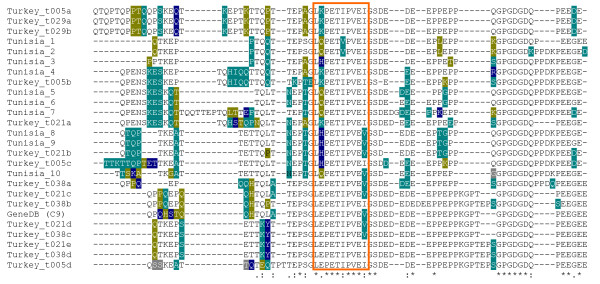
Hypervariable region of SVSP1. Amino acid sequences representing alleles of SVSP1 were aligned, identifying hypervariability in the PEST domain in the centre of the protein. At each site the second (green), third (gold), fourth (blue) and fifth (grey) most frequent amino acids are indicated and the conserved motif L(Q/*)PET(V/I)PVE(V/I) is highlighted.